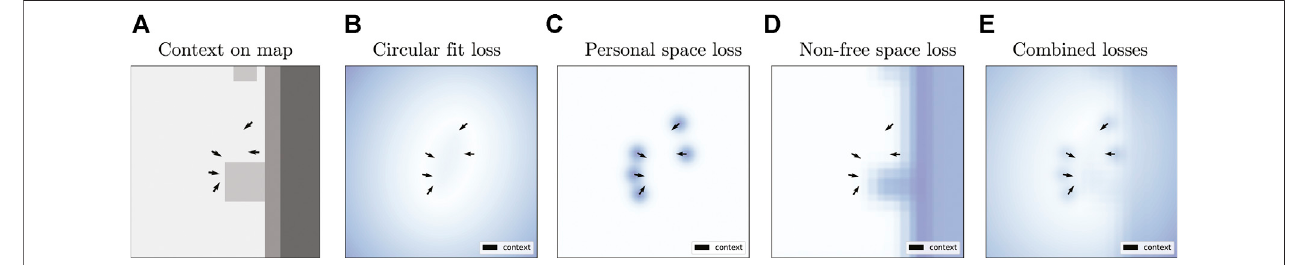
FIGURE 2 | Example losses for the Geometric approach on a sample from the Cocktail Party dataset. From left to right: (A) social context on an environment map with free space (light gray color), short obstacles (medium gray), and tall obstacles (darker gray); (B) circular fi t loss; (C) personal space loss; (D) penalty associated with nonfree cells of the environment map; and (E) weighted sum of those three losses. The arrows indicate the pose of the interactants. Brighter values in the loss plots correspond to lower cost.